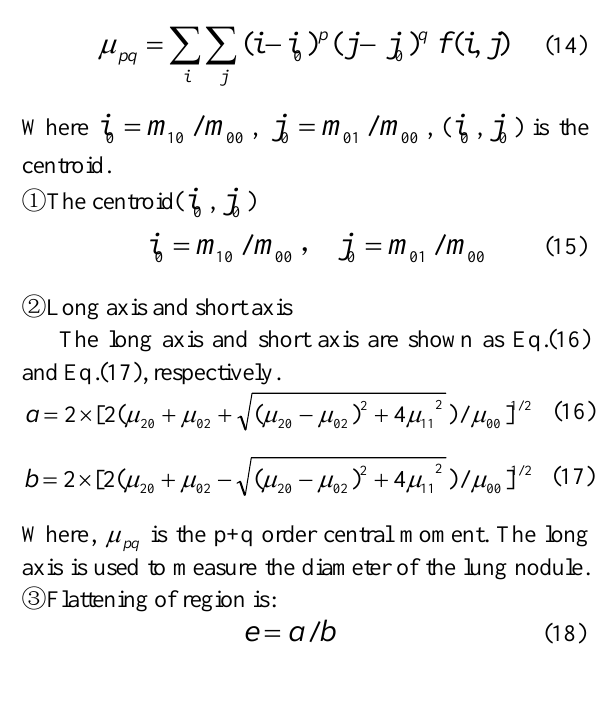
Fig. 9. Result of the suspected solitary lung nodules segmentation. (a)original image, (b)NAD filtering enhancing, (c)the proposed